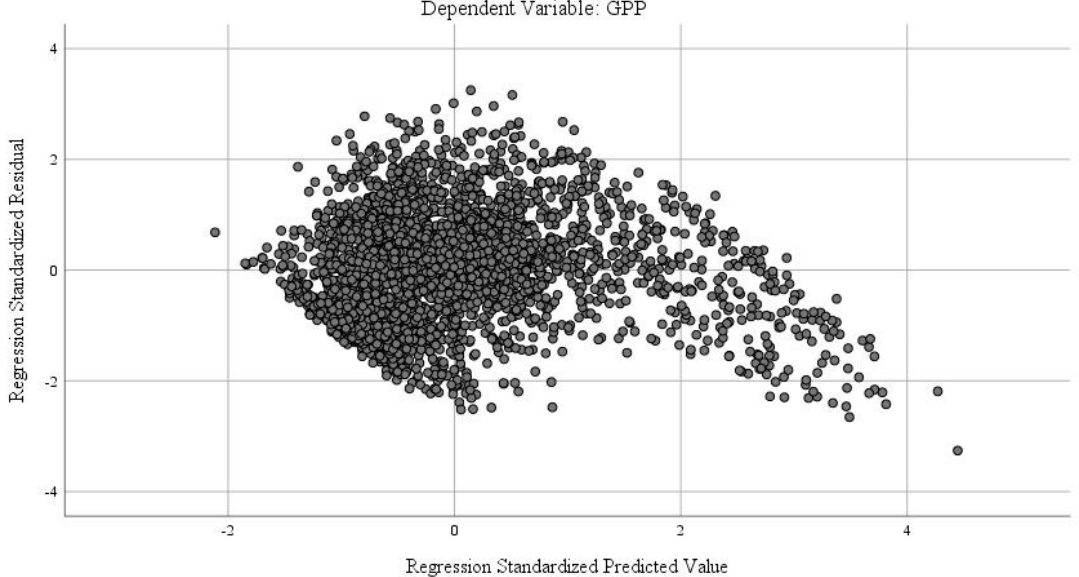
Figure A6. Scatterplot of the standardized residuals and the standardized predicted values using the original values of the class grasslands for the year 2000.